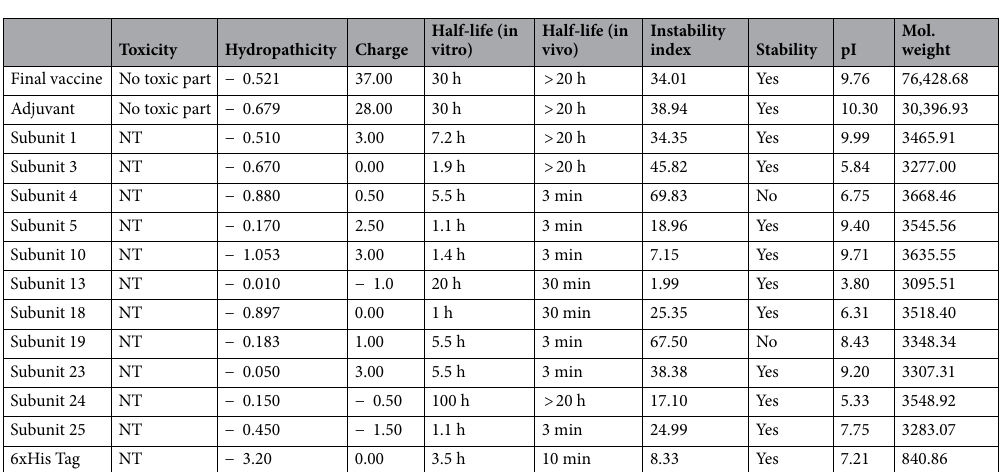
Table 10. Toxicity and physicochemical properties prediction results. NT: none-toxicity. We use the protein screening mode in the ToxinPred server to check the overlapping peptides in the final vaccine and adjuvant sequence and they do not contain any toxic peptide. For the rest subunits, we directly use the SVM based prediction to predict their